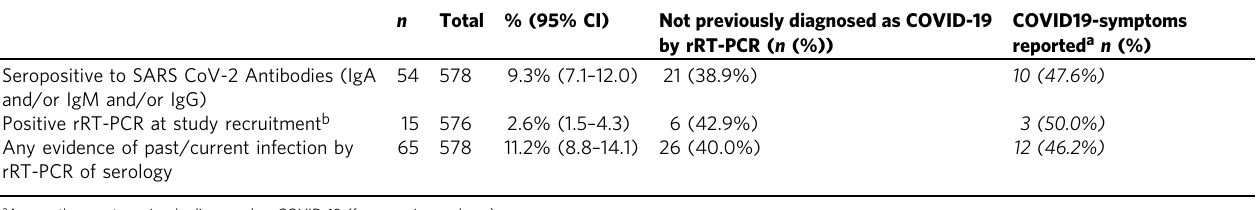
Table 2 Overall proportion of HCW with (a) detectable antibodies, (b) history of past positive rRT-PCR, (c) Positive rRT-PCR at study recruitment, and (d) Cumulative prevalence of infection (past/current rRT-PCR and/or antibodies). n Total % (95% CI) Not previously diagnosed as COVID-19 by rRT-PCR ( n (%)) Seropositive to SARS CoV-2 Antibodies (IgA and/or IgM and/or IgG)